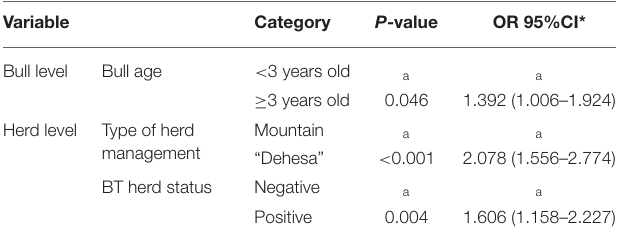
TABLE 3 | Results of the logistic regression analysis of potential risk factors associated with Campylobacter fetus subsp. venerealis in breeding bulls and extensive beef cattle herds in